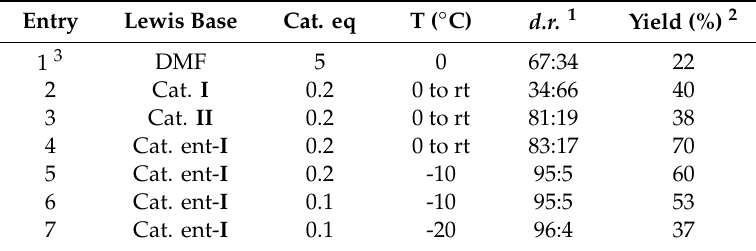
Table 1. Diastereoselective catalytic reductions.